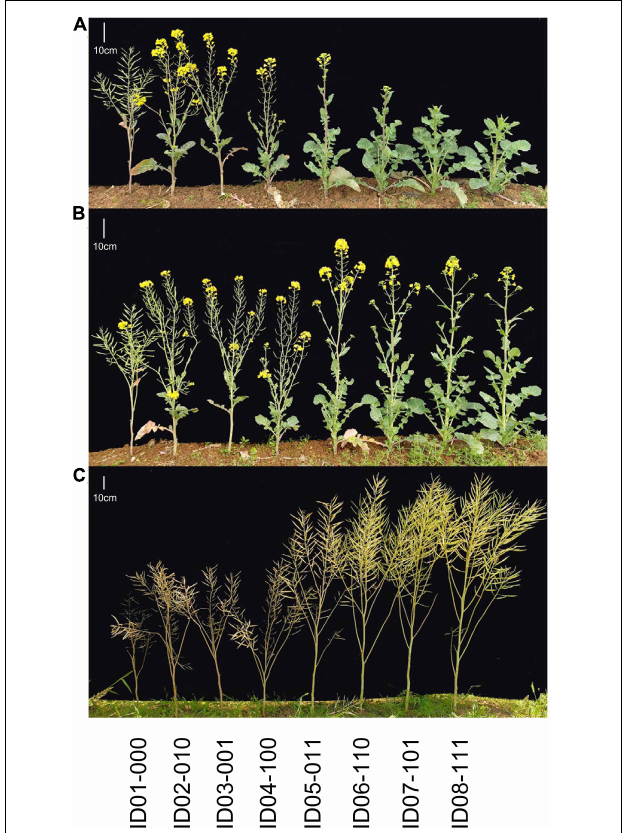
FIGURE 4 | Continuous observation of growth status for the eight genotypes in the Wuhan environment. (A) February 21, 2020. (B) February 29, 2020. (C) April 28, 2020. From left to right: ID01-000, ID02-010, ID03-001, ID04-100, ID05-011, ID06-110, ID07-101, and ID08-111.